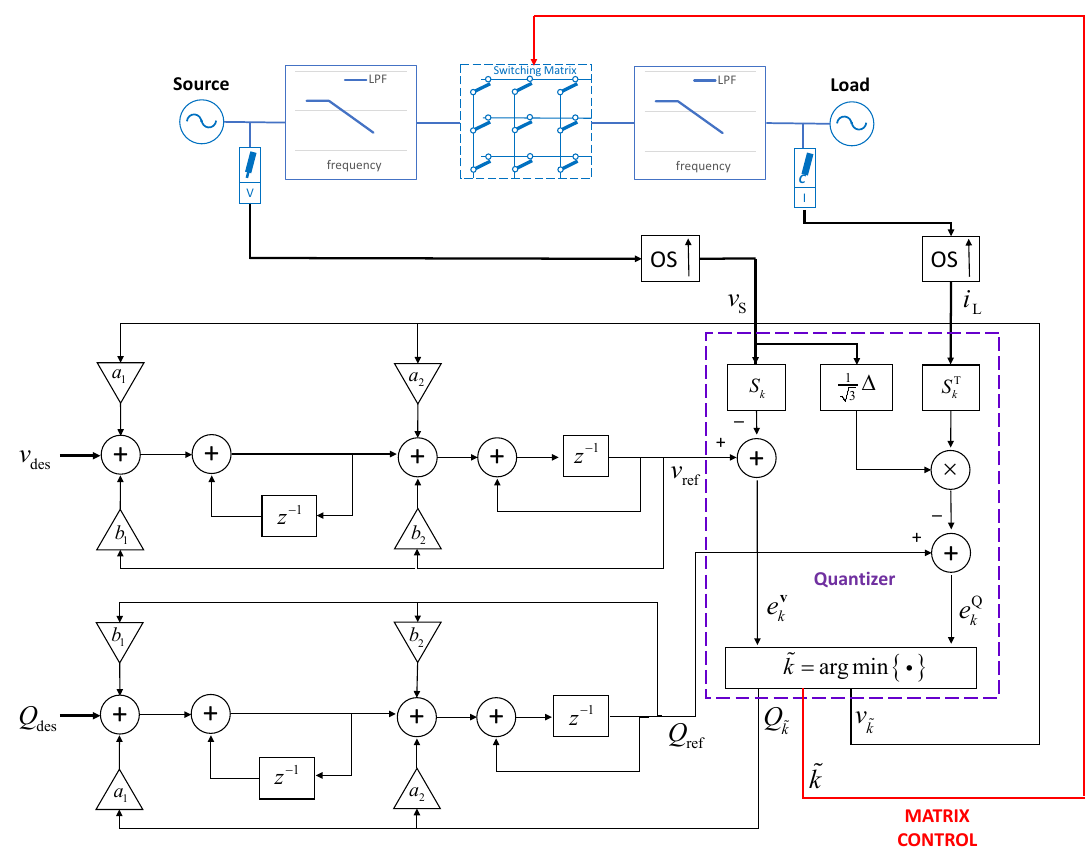
Figure 2. The Sigma-Delta digital modulator, acting as controller of the matrix